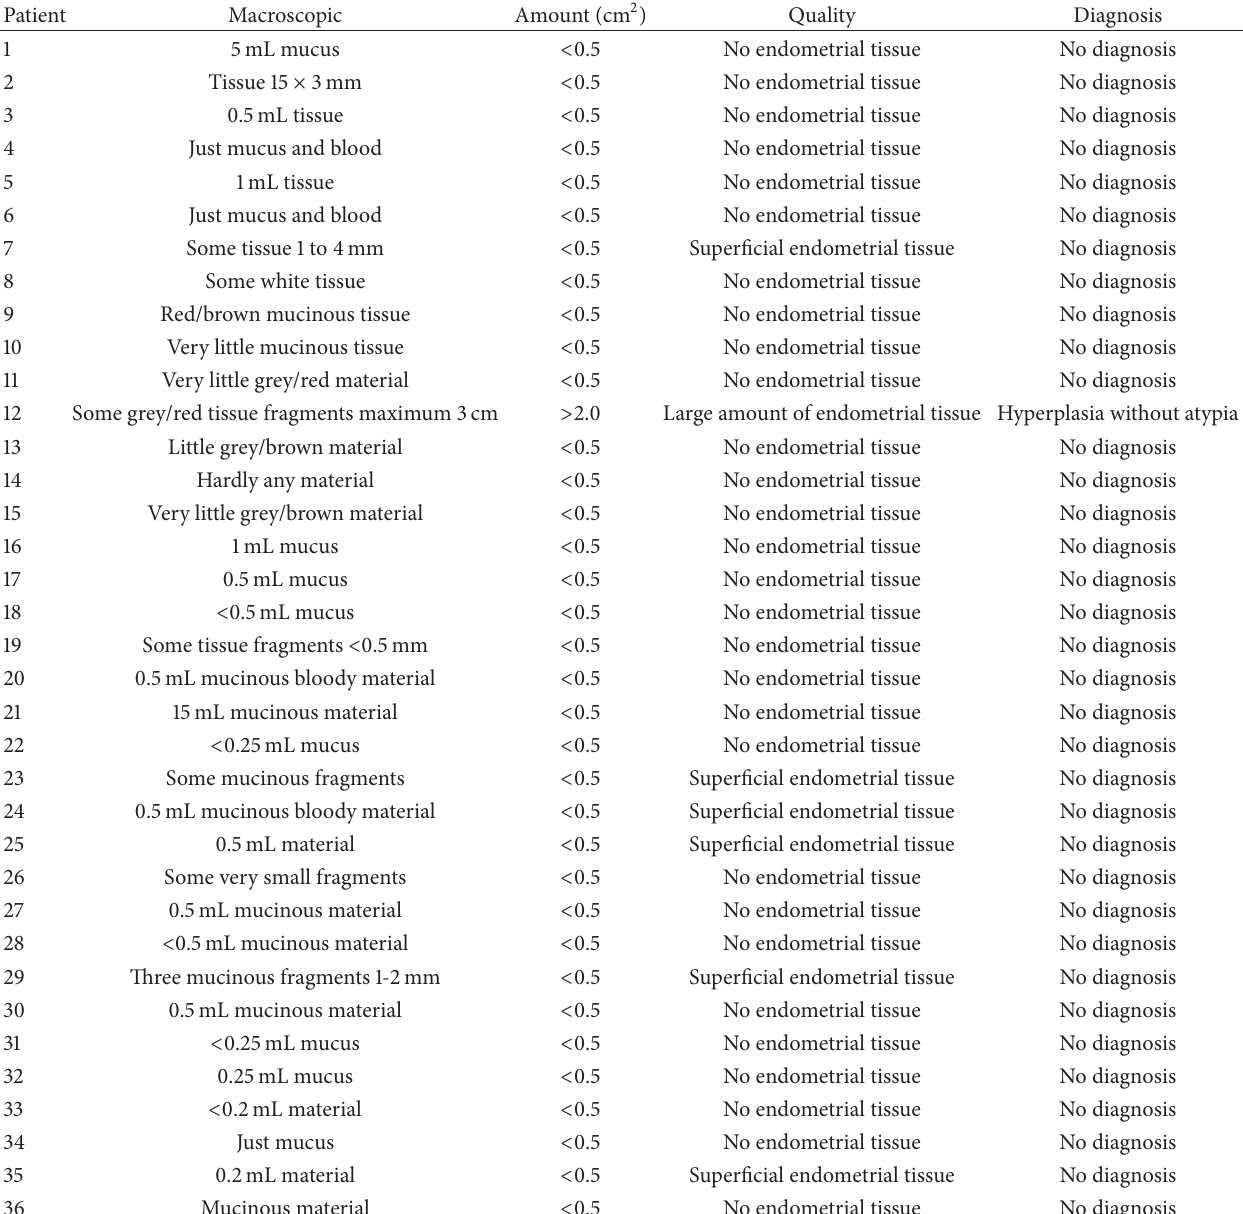
Table 2: Reassessment of endometrial samples.